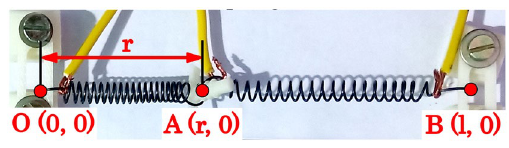
Fig. 8 Nitinol SMA springs arranged in series